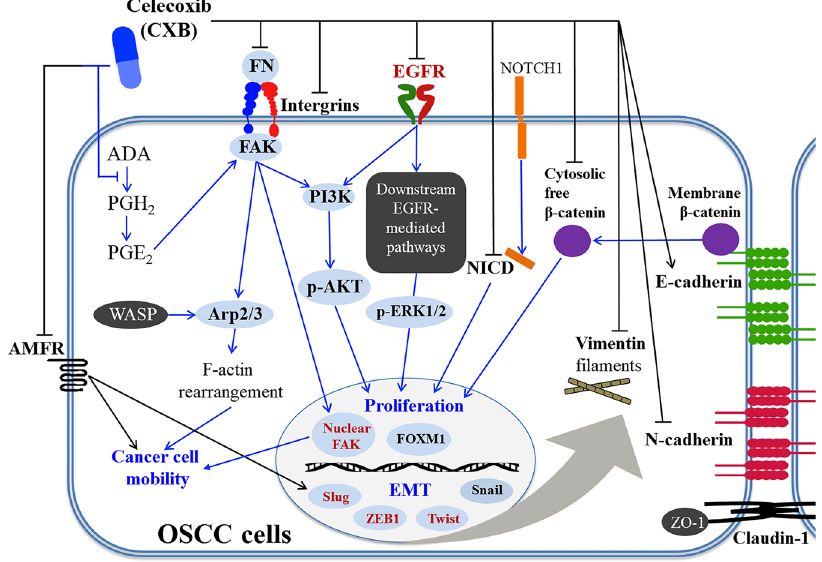
Figure 4. The possible molecular mechanism of CXB in the chemoprevention of OSCC cancer progression. The protein levels of selected biomarkers in bold were investigated in the cell models, and the four biomarkers in red were further analysed in a mouse xenograft